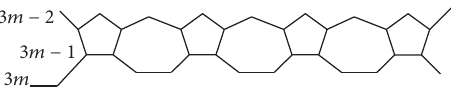
Figure 1: 𝑖 th period of SC 5 C 7 [𝑝,𝑞]